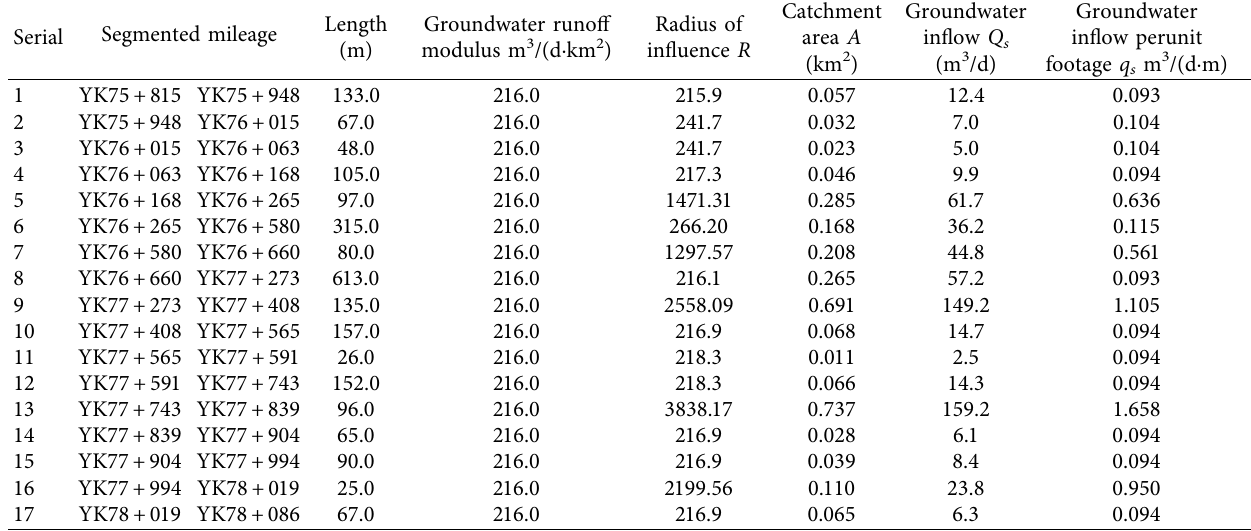
Table 5: Prediction of groundwater inflow into the right tunnel based on the groundwater runoff modulus method. Serial